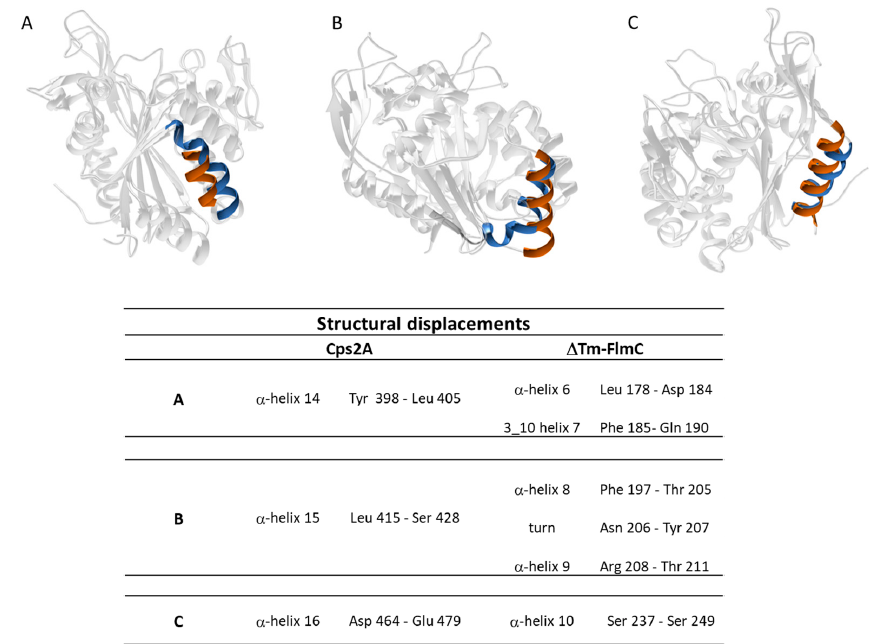
Figure 4. Panel A , B and C show the main structural differences between Δ TM-FlmC (blue) and Cps2A (red); the structural elements shown are reported in the